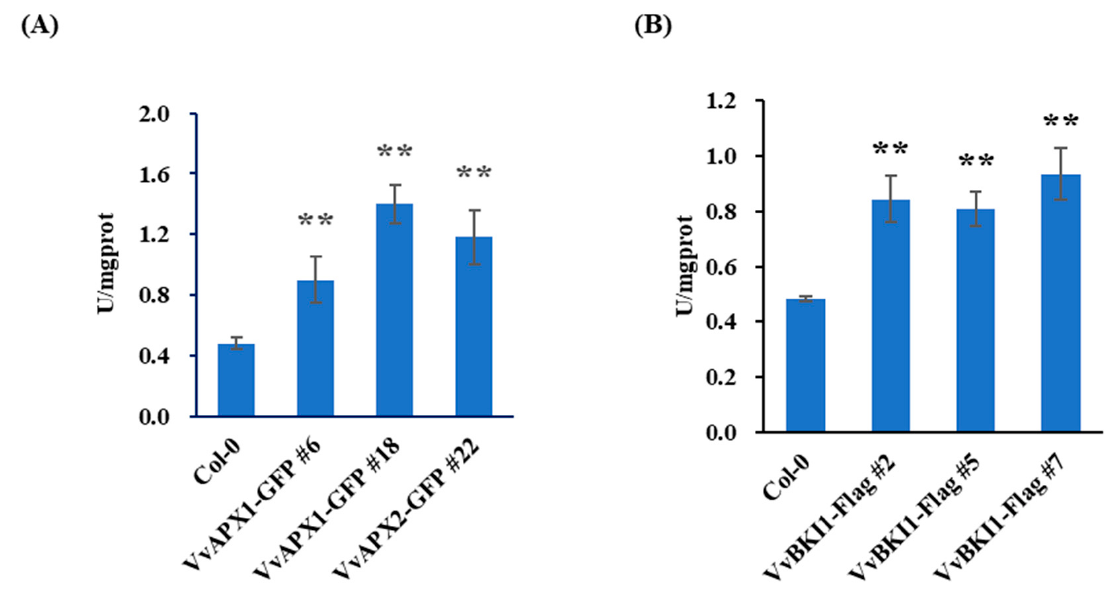
( A ) Ectopic expression of VvAPX1 in Arabidopsis increases plant enzyme activity. ( B ) Ectopic expression of VvBKI1 in Arabidopsis increases plant enzyme activity. Total protein from rosette leaves of four-week-old Arabidopsis were used to check APX activity. Data are shown as means ± SD ( n = 3). ** represents extremely significant difference ( p < 0.01, Student’s t